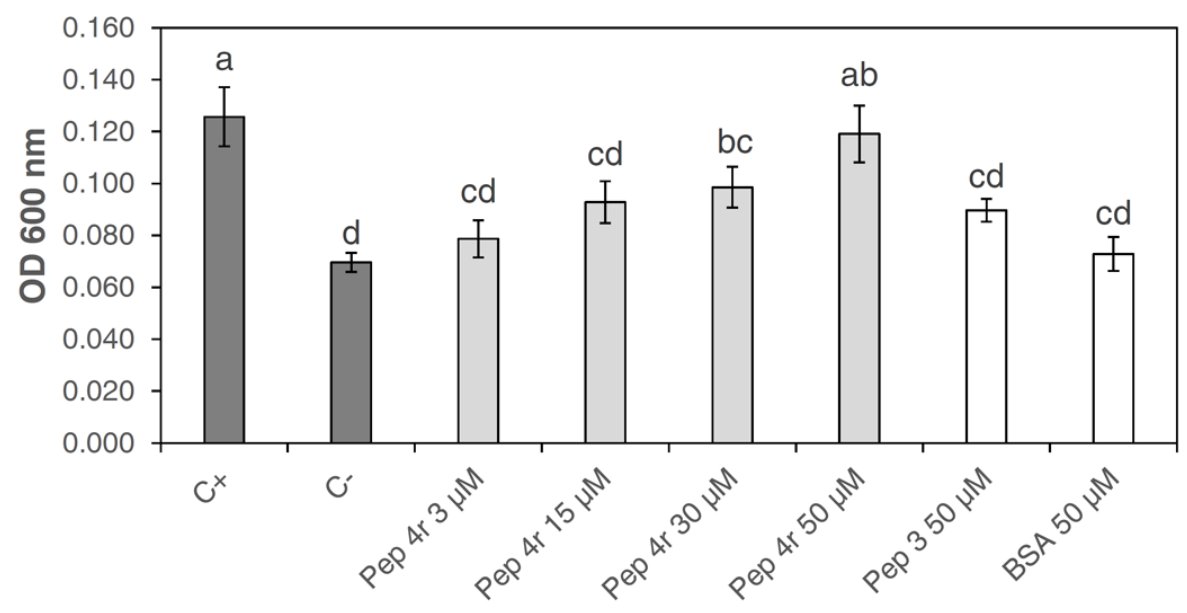
Figure 3. Cytotoxicity analysis evaluated by Evans Blue staining towards tobacco cells treated with peptide 4r at different concentrations. Peptide 3 at 50 µ M was included as a non-active peptide because it has no antibacterial activity. Boiled tobacco cells were used as a positive control (C+). Tobacco cells treated with water (C-) or with BSA at 50 µ M were used as negative controls. Three technical and three biological replicates were used in three different experiments. Data were statistically analyzed by a one-way ANOVA followed by the Tukey–Kramer Post Hoc Test. Different letters indicate significant differences at p < 0.05.